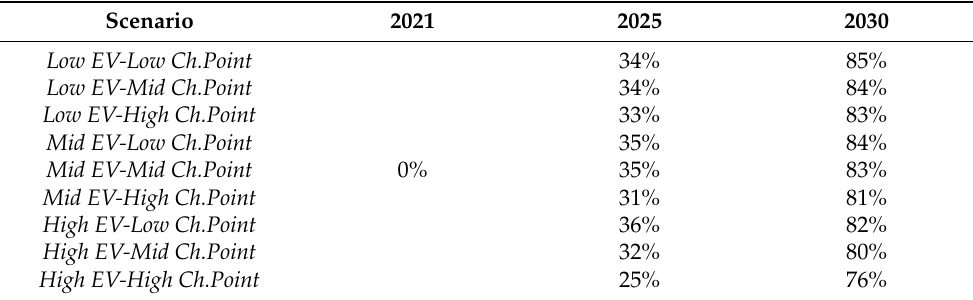
Table 9. Share of charging stations deployed by the private sector in the total available charging sta- tions.